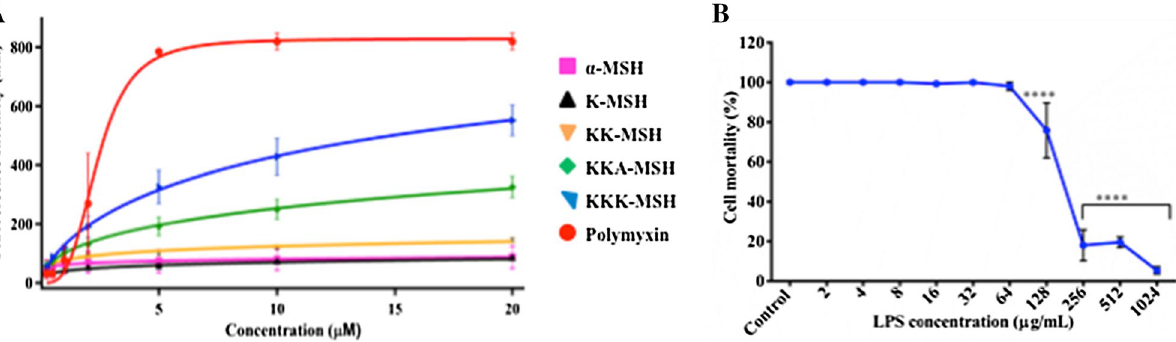
Figure 4. ( A ) LPS binding affinity of α-MSH and its cationic analogues was determined by BC displacement assay. The experiment was conducted on two independent days, and each data point represents the average value ± SE. The curves were fitted as described in the Materials and Methods section. ( B ) E. coli cell mortality at a fixed concentration (10 µM) of KKK-MSH, as a function of various lipid concentrations. The experiment was conducted on three independent days, and each data point represents the average value ± SE. The experiment was performed twice, and similar data was obtained. Representative data from one set is shown here. (** P < 0.01 and **** P < 0.0001, compared to the parent peptide at corresponding concentration).